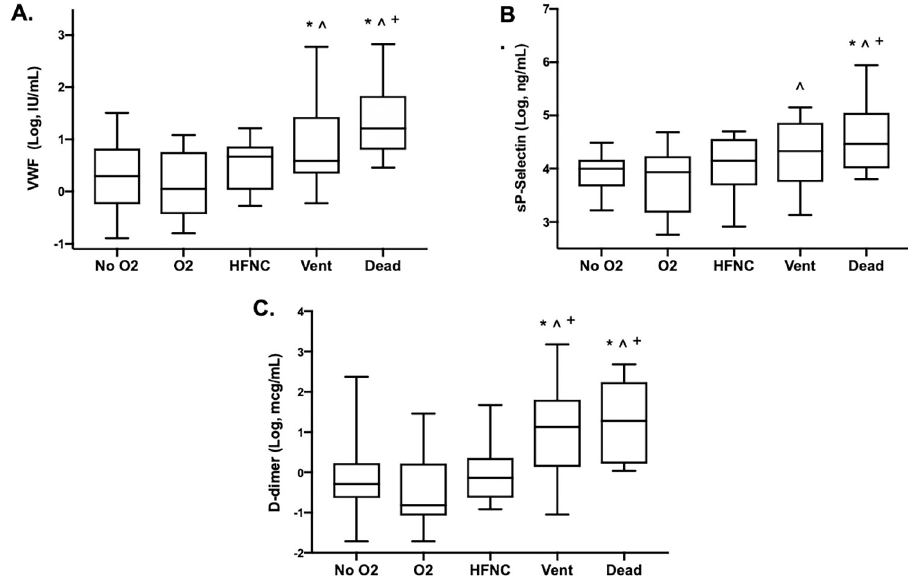
Fig 1. Increased severity of COVID-19 is associated with higher levels of endothelial cell activation and fibrinolysis biomarkers. The plasma levels of A) VWF, B) sP-Selectin, and C) D-dimer were measured in blood samples obtained from COVID-19 patients. Lines denote median levels with error bars representing minimum and maximum values. Sample sizes: No O2 (N = 20), O2 Rx (N = 20), HFNC (N = 15), Vent (N = 19), and Dead (N = 9). � p < 0.05 compared to No O2 group; ^ p < 0.05 compared to O2 group; + p < 0.05 compared to HFNC group.